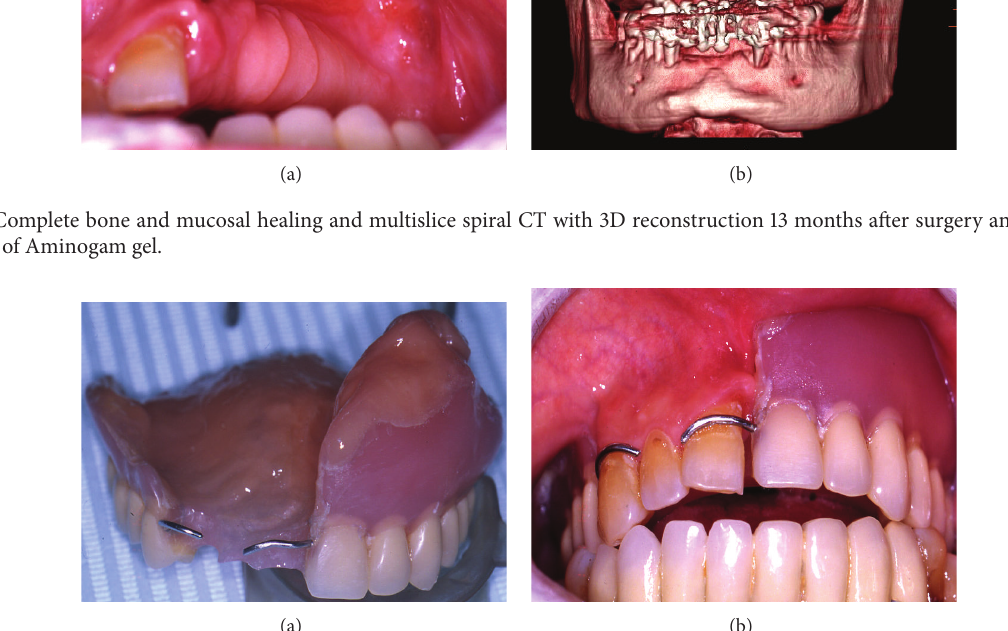
saline solution and hydrogen peroxide, at least three